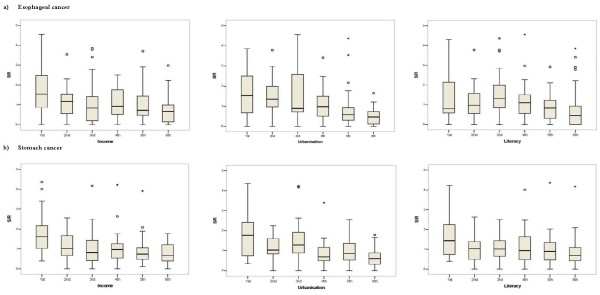
Relationship between esophageal (a) and gastric (b) cancer SIRs, and sextiles of the following three socio-economic score factors: income, urbanisation, and literacy. Each boxplot within each panel displays the distribution of the SIRs within that sextile.